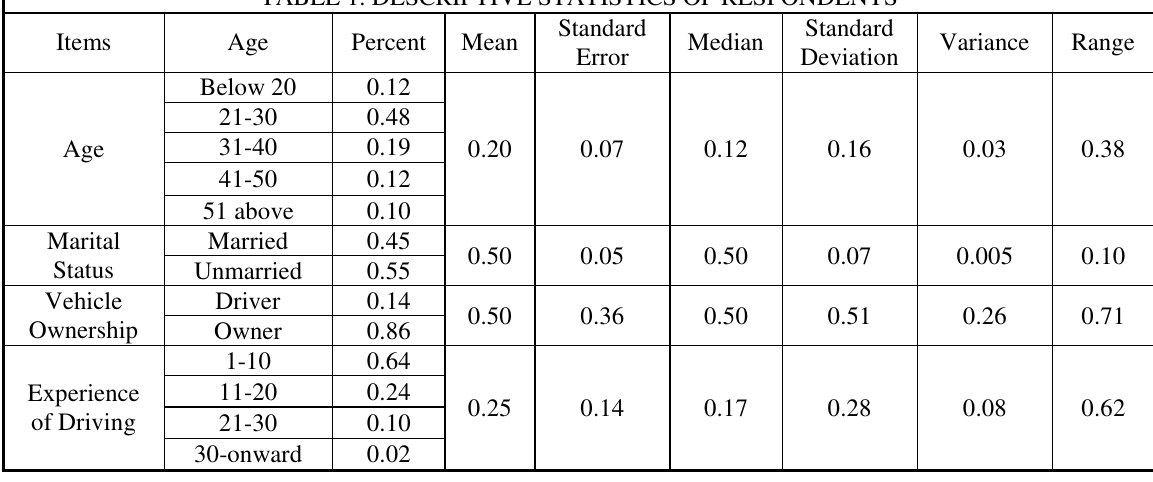
TABLE 1. DESCRIPTIVE STATISTICS OF